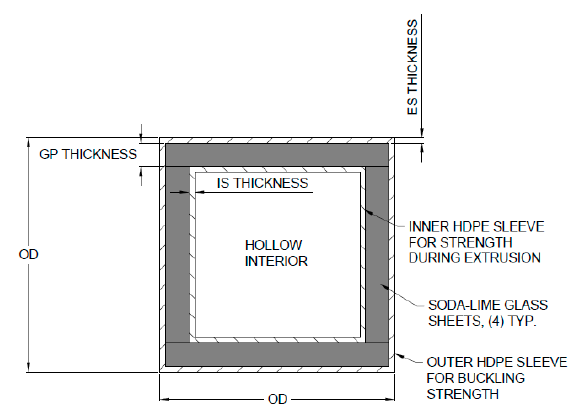
Figure 11. The general arrangement of the GRCC that works as a replacement for HSS columns.